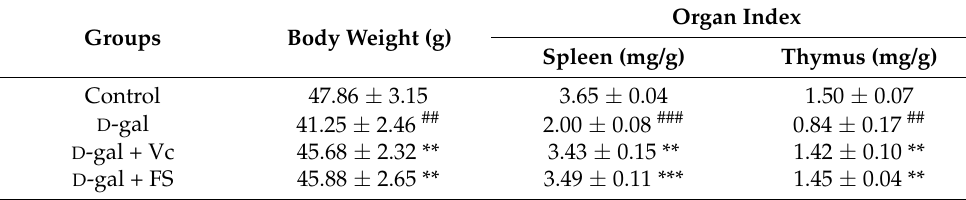
Table 4. Effects of MCE on body weight and organ